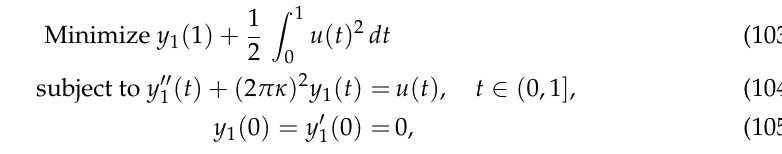
Figure 3. Controlled Motion Problem: optimal path ( y (cid:63) 1 + 1 − 1 y 2 y 4 y 2 visualized by isolines and exhibiting a saddle point structure ( top ). Convergence of the 2 1 1 2 2 4 maximal state errors (cid:107) ( w T ⊗ I ) Y n − y ( t n + 1 ) (cid:107) ∞ ( bottom left ) and adjoint errors (cid:107) ( v T ⊗ I ) P n − p ( t n ) (cid:107) ∞ ( bottom right ), n = 0, . . . , N